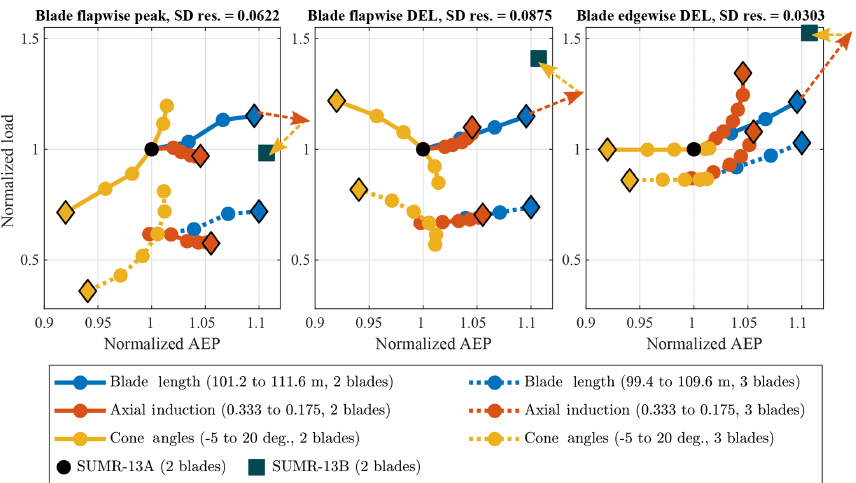
Figure 9. The trade-off between power capture and blade loads. The AEP is plotted on the x axis and blade loads are plotted on the y axis. All rotors are normalized to the two-bladed 101.2m SUMR-13A baseline rotor design (black dot). Each dot represents a rotor design and each curve represents the variation of one design parameter. The set of three-bladed rotor designs is represented with dotted curves. Unless otherwise specified, the available rotor power is 13.9MW, the axial induction is 1 , and the cone angle is 5 ◦ ; the SUMR-13B is specified in 3 Table 1. The normalized residual standard deviation for AEP is the same as in Fig. 8, and the load residual standard deviations are normalized to the corresponding SUMR-13A values. The vectors indicate design changes in combination: blade length increase (blue diamond), axial induction factor decrease along with corresponding blade length increase (red, dashed vector), and cone angle increase (yellow, dashed vector) from the SUMR-13A to the SUMR-13B